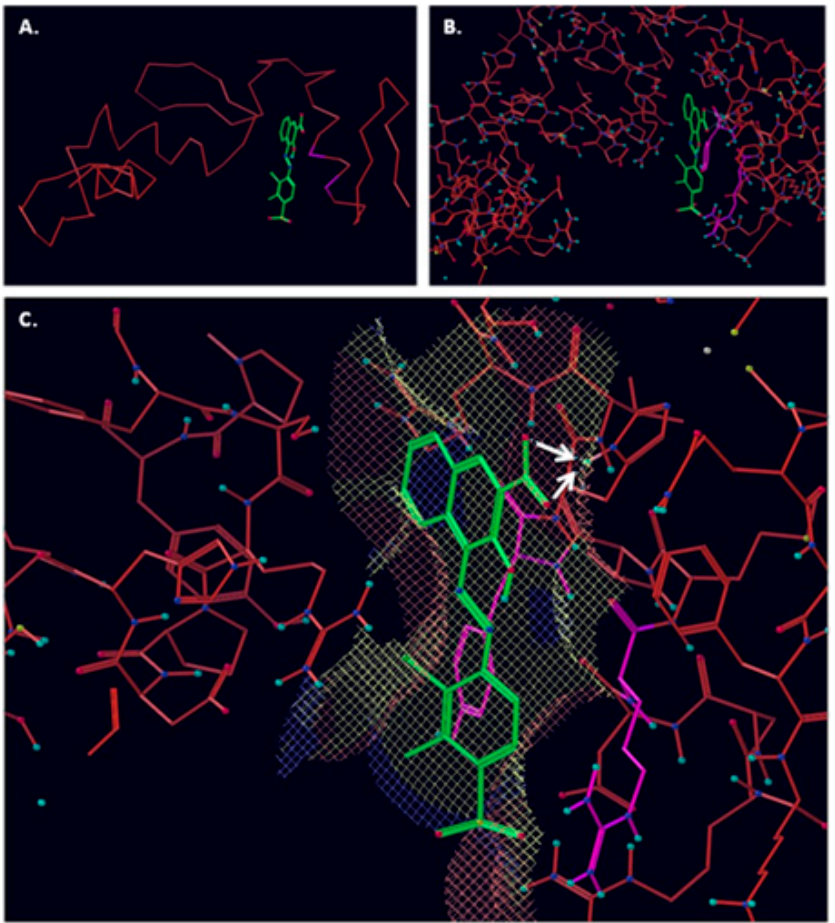
Figure 2. NSC16087 docked into Model II binding site. In ( A ) alpha carbon trace, in ( B ) complete model and in ( C ) NSC16087 docked into Model binding site with the accessible surface mesh. Hydrogen bonds to His 48 are shown with white arrows.